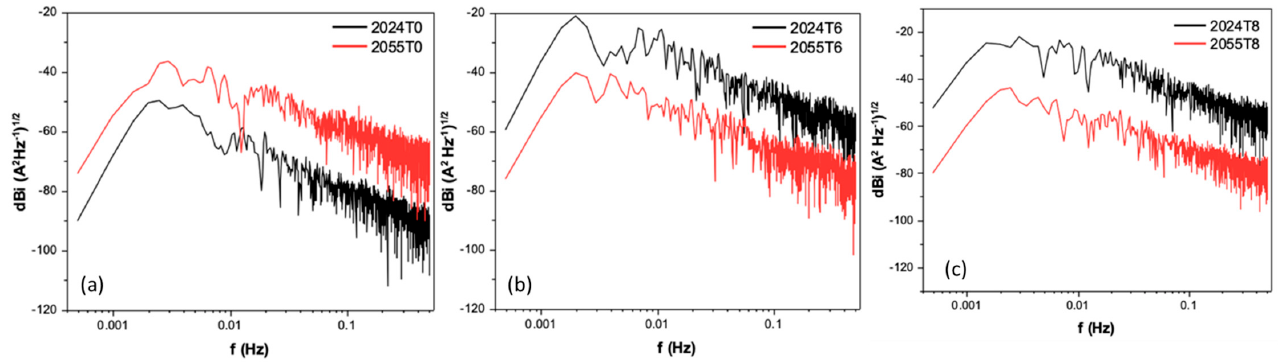
Figure 10. Power spectral density (PSD) in current, for aluminum alloys under ( a ) T0, ( b ) T6, and ( c ) 8 heat treatment conditions, exposed to a 3.5 wt. % HCl solution.